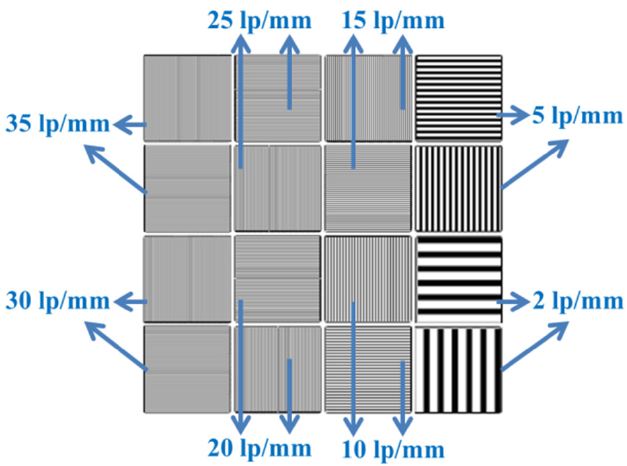
Photonics 2022 , 9 , x FOR PEER REVIEW Figure 9. Schematic diagram of the spatial resolution mask. Figure 9. Schematic diagram of the spatial resolution mask.